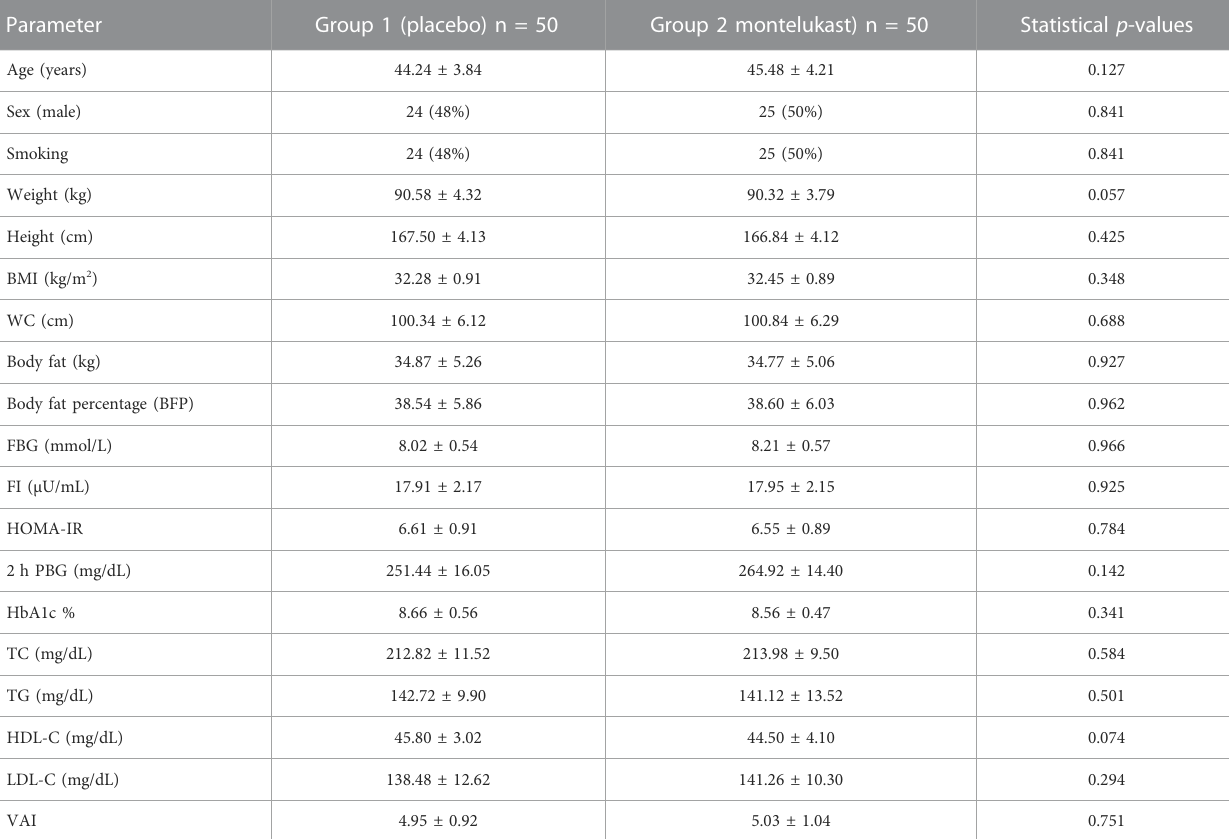
TABLE 1 Baseline demographic, anthropometric, and laboratory data for the two study